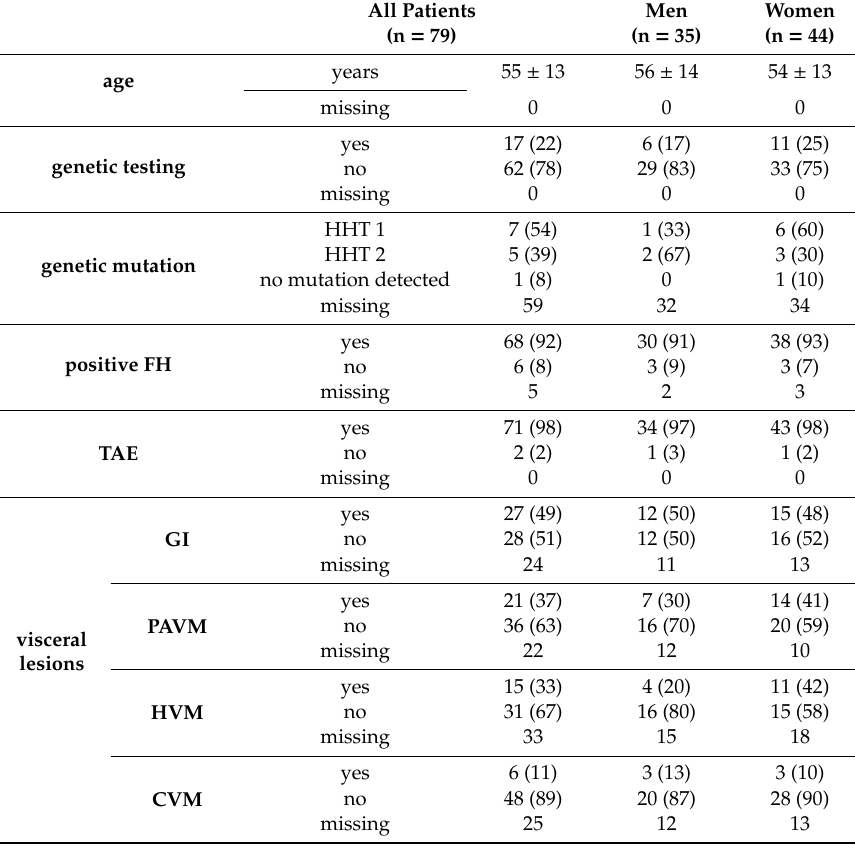
Table 1. Clinical manifestations of 79 patients with